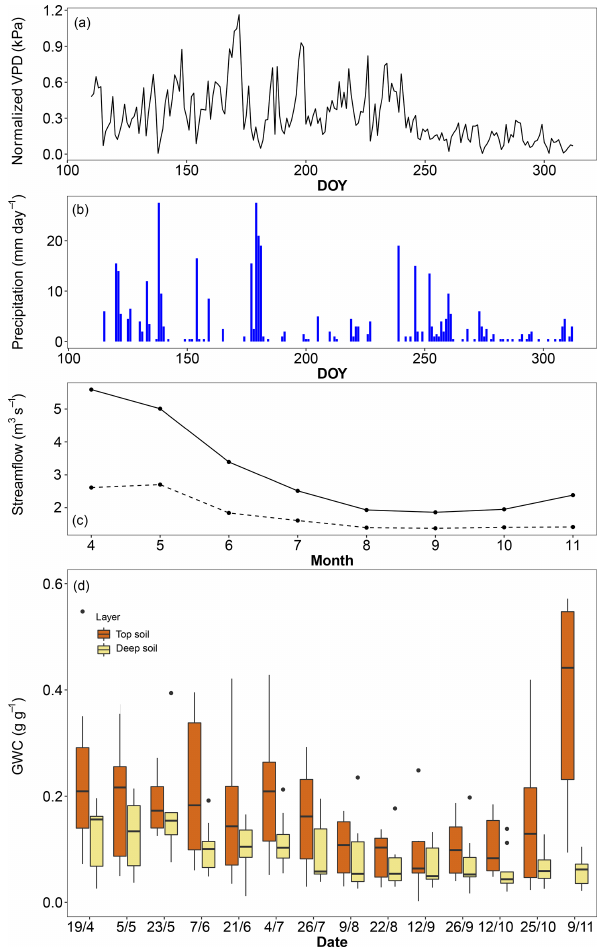
Figure 1. Environmental conditions in the riparian forest along the Ciron river during the 2017 growing season. (a) Daily vapour pres- sure deficit (VPD), (b) daily precipitation, (c) monthly streamflow for 2017 (dashed line) and the 2010–2017 period (solid line), and (c) gravimetric water content of top soil (0–10cm) and deep soil (ranging from 50 to